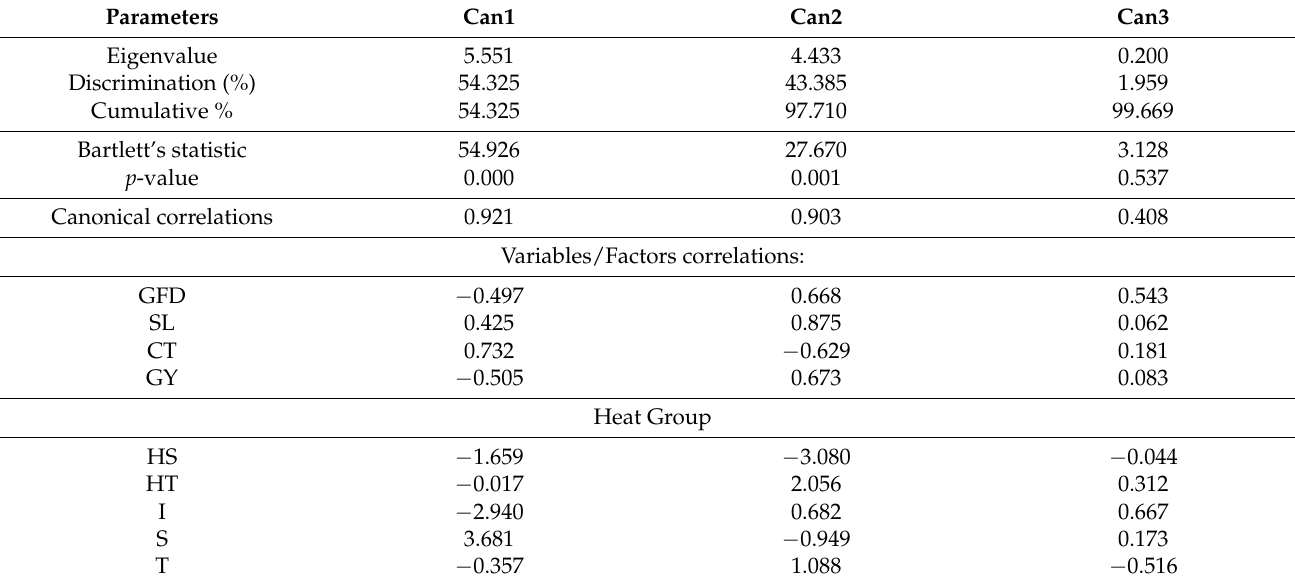
Table 8. Total canonical structure of eigenvalue, canonical discriminant function, bartlett’s statistic, and class means of heat group to canonical discriminant function.